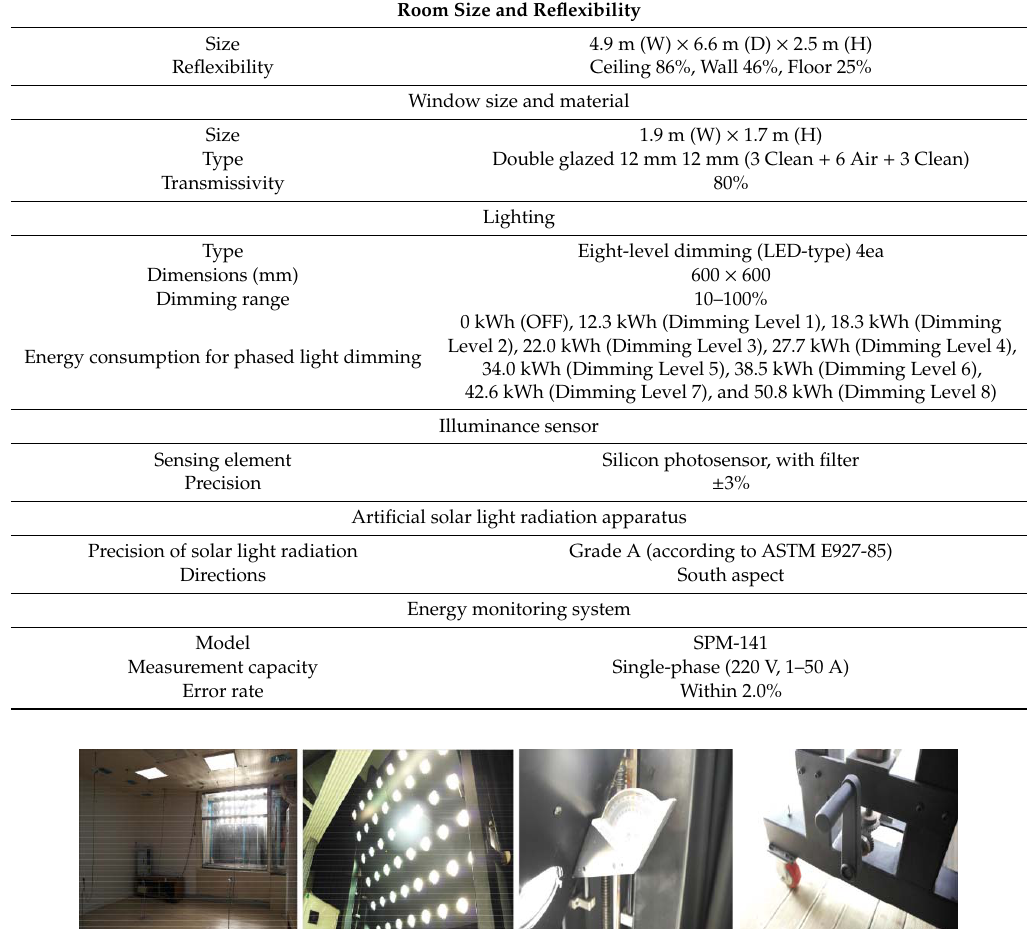
Table 3. Overview of testbed.